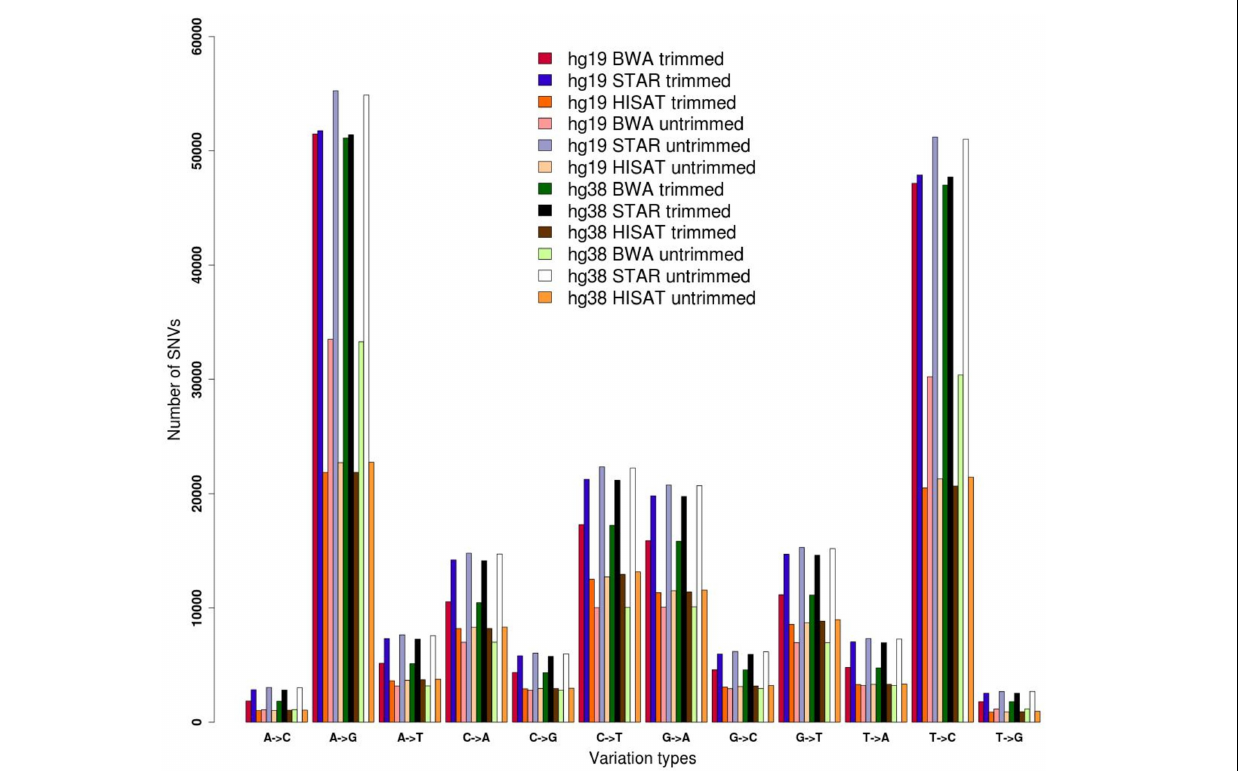
FIGURE 1 | Distribution of single nucleotide variants detected by REDItools on trimmed and untrimmed reads (from accession SRR607967) aligned by means of BWA, STAR, and HISAT2 onto hg19 and hg38 human genome assemblies.